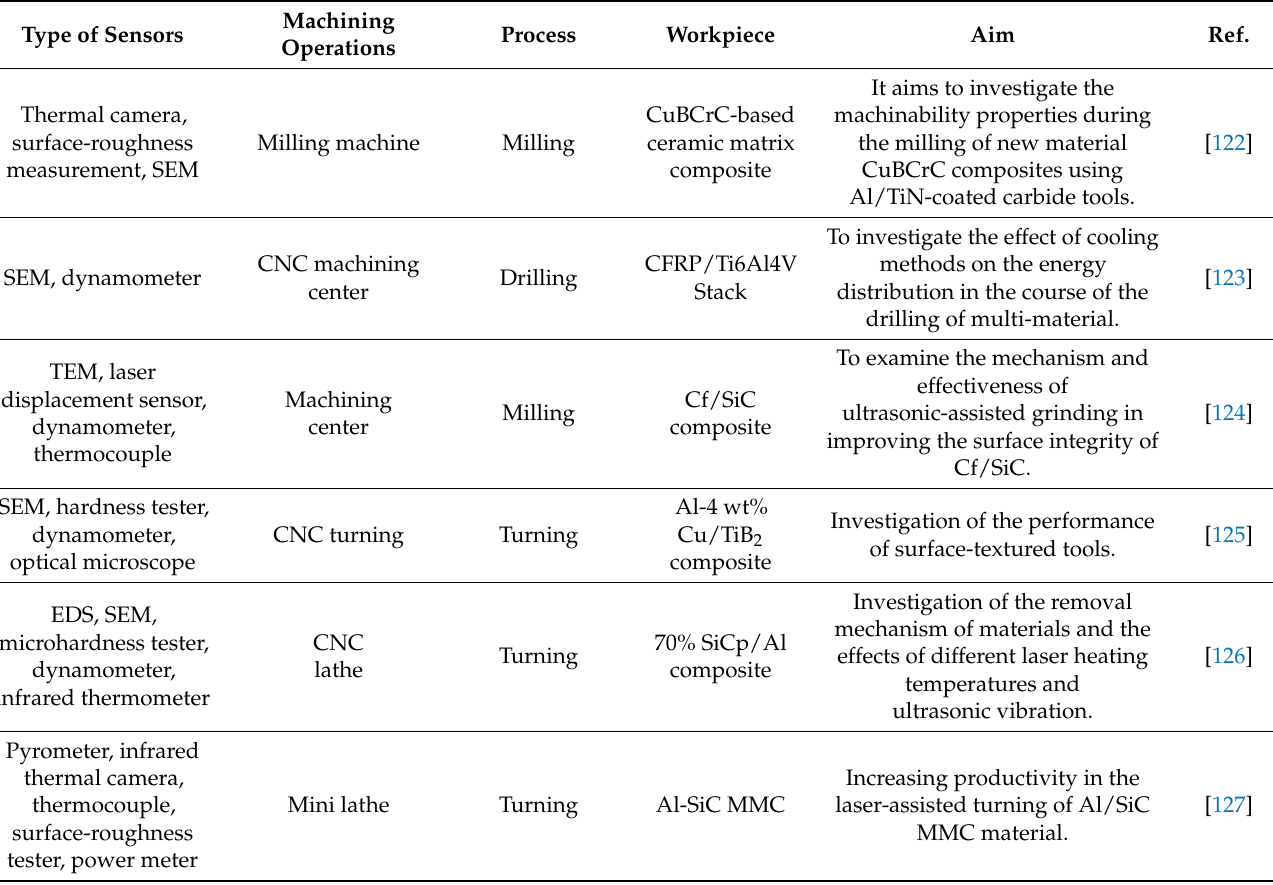
Table 6. Literature review of power and energy consumption studies on